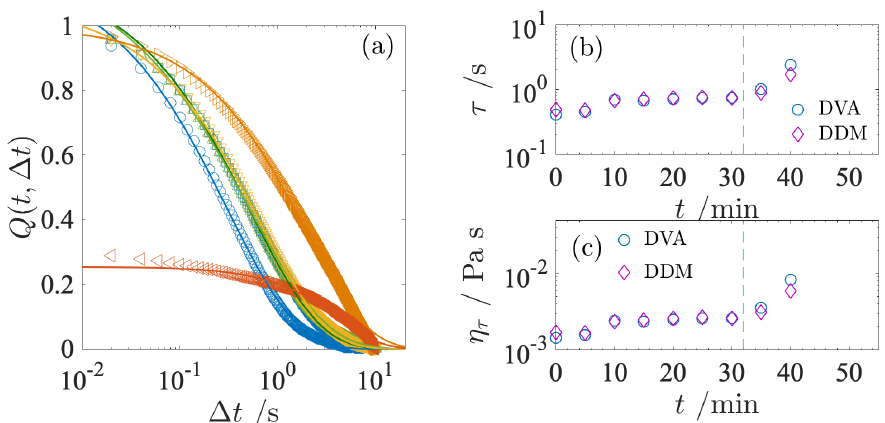
Figure 5. ( a ) DVA curves Q ( t , ∆ t ) calculated at different t . Solid curves are the best fit to Equation (2). In this panel, each symbol corresponds to 0 min ( (cid:13) ), 10 min ( (cid:3) ), 20 min ( (cid:52) ), 30 min ( (cid:79) ), 40 min ( (cid:46) ), and 50 min ( (cid:47) ), respectively. Relaxation time τ obtained from the fitted results is shown in ( b ). Microscopic viscosity η τ calculated is shown in ( c ). In the panel ( b , c ), both data obtained from DVA and DDM are plotted. Vertical dashed line shows t c = 32